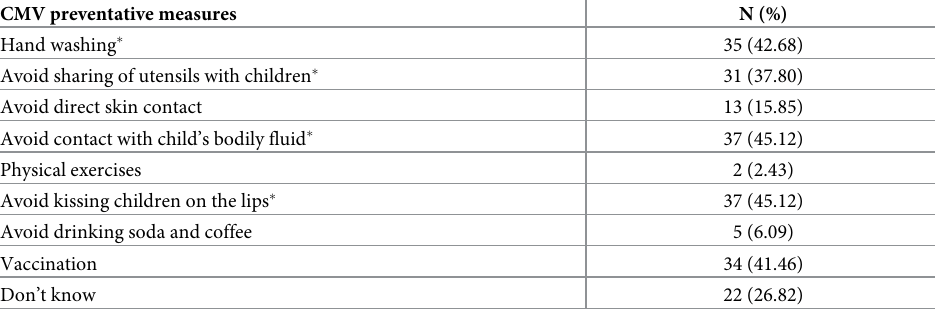
Table 4. Knowledge of preventative measures against CMV among survey respondents that previously heard of